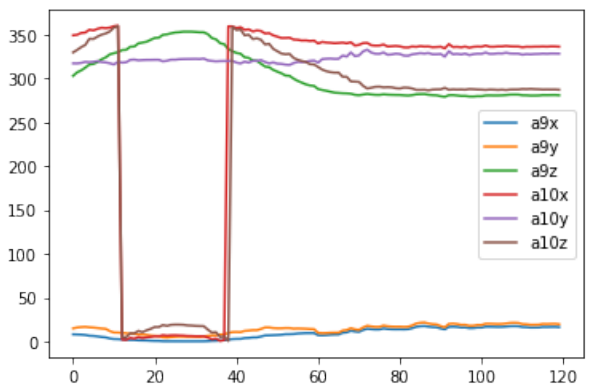
Figure 6. The change of 6 rotation angles of a movement over time, 4 sec- onds resulted in 120 frames and range from 0 to 360 degrees.